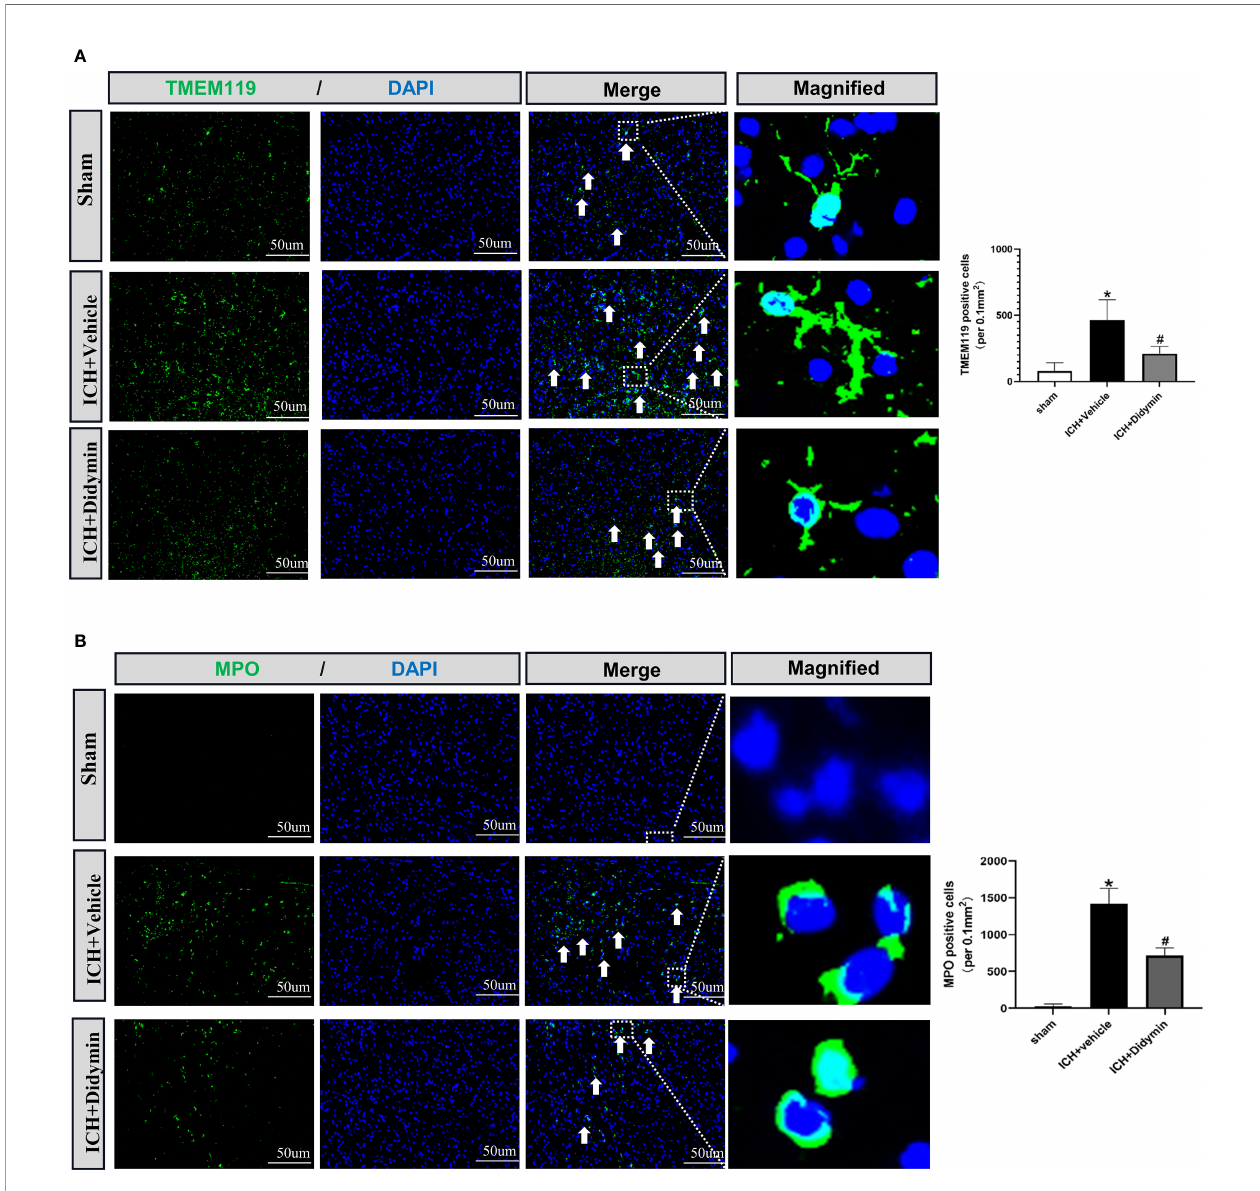
FIGURE 4 | Didymin treatment suppressed microglial activation and neutrophil in fi ltration. (A, B) Images of TMEM119 and MPO immunostaining and quantitative analysis of Iba-1-positive and MPO-positive cells. Scale bar = 50 m m. n = 3 for each group. * p < 0.05 vs. sham; # p < 0.05 vs.